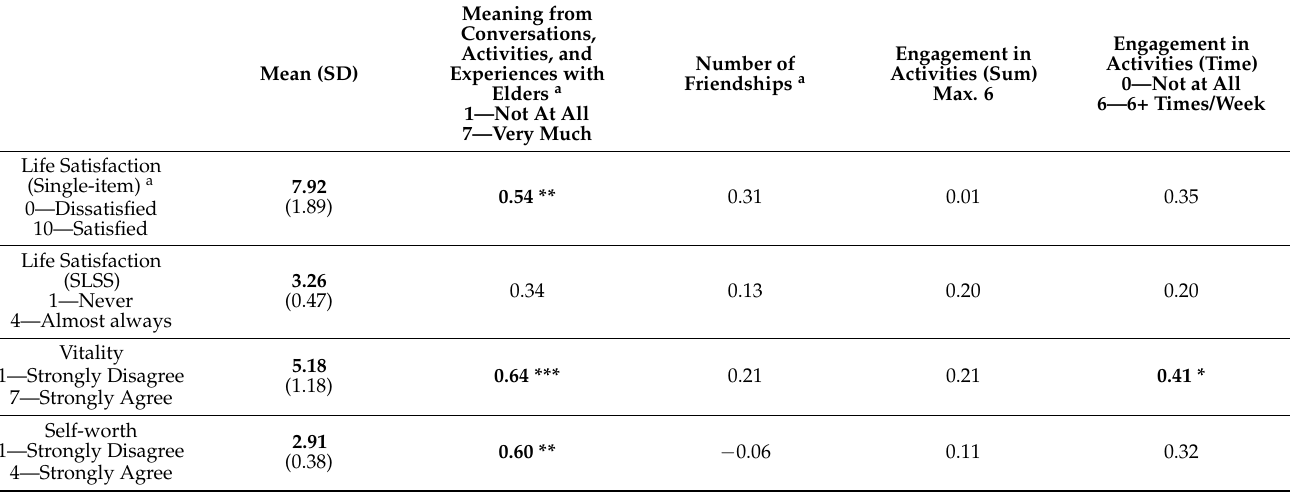
Table 2. Item means and bivariate correlations between meaning, friendships, engagement, well- being, and